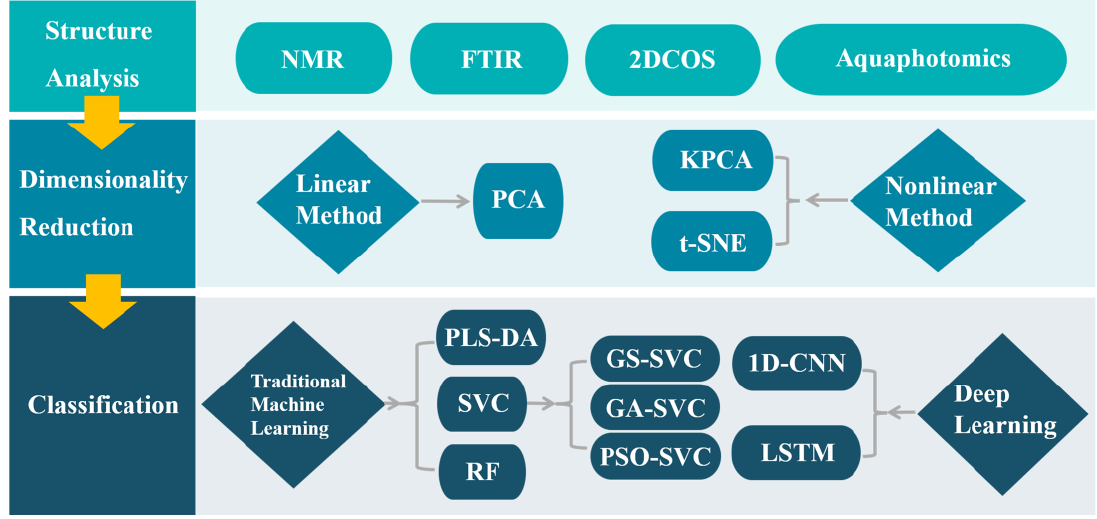
Figure 1. A flow diagram of this study.